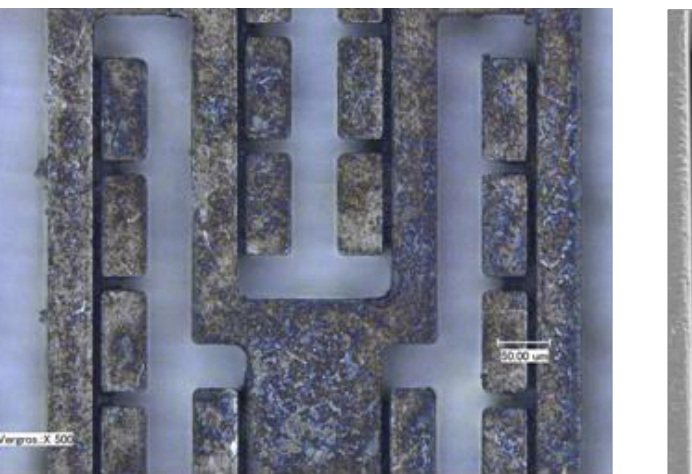
Figure 4. Left: LIGA tool from nickel; Right: Microstructure embossed from that tool